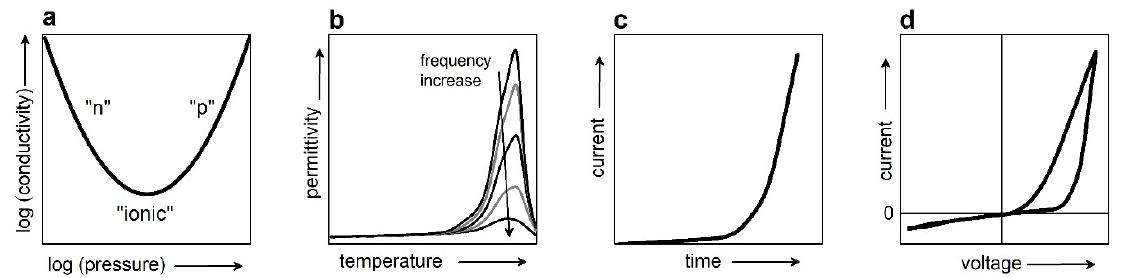
Figure 1. Typical electric behavior of perovskite oxide piezoelectric materials. Schematics of ( a ) V-shaped log–log curve of DC conductivity versus oxygen pressure, ( b ) high-temperature frequency-dependent permittivity peak, ( c ) current during DC degradation, and ( d ) resistive switching. Arrows show directions of parameters increase.